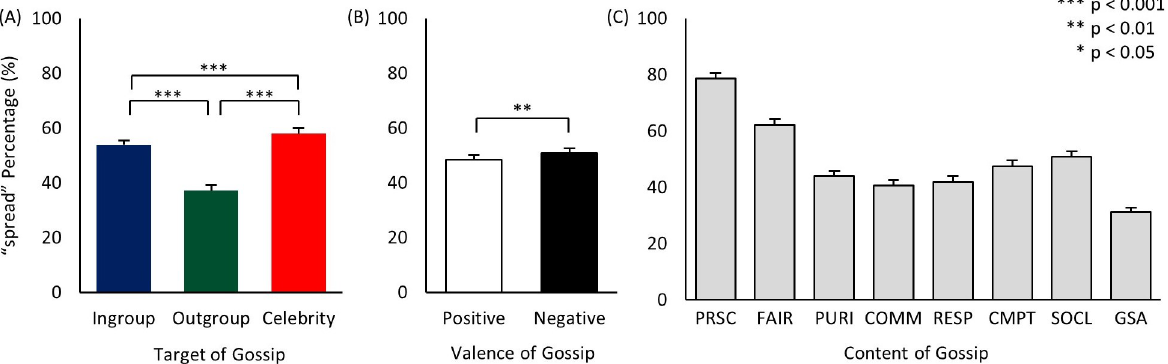
Fig 4. Mean spread rates of target, valence, and content of gossip (i.e., main effects). (A) Mean spread rates of ingroup, outgroup, and celebrity gossip. (B) Mean spread rates of positive and negative gossip. (C) Mean spread rates of eight different contents of gossip (see S1 Table in S1 Text for statistical significance): PRSC (prosociality), FAIR (fairness), PURI (purity), COMM (community), RESP (respect), CMPT (competition), SOCL (social-oriented), GSA (general social affairs). �� p < 0.01, ��� p < 0.001.